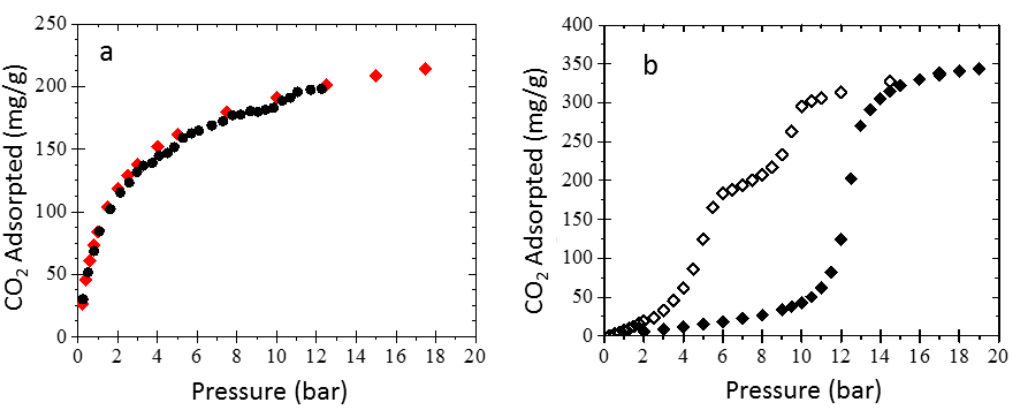
Figure 11. Comparing CO 2 adsorption data at 30 ◦ C for Ni-BpyMe powder (black) and single-crystal (red) samples. Plot ( b ) is shown to contrast the adsorption (solid)–desorption (open) behavior for CO 2 at 30 ◦ C on the flexible PICNIC Ni-Bpene to that of the rigid Ni-BpyMe sample, plot ( a ).